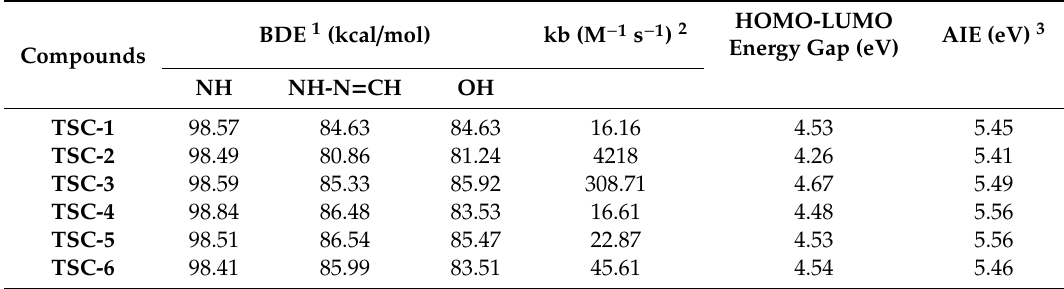
Table 2. Rate constants(kb) for radical scavenging, HOMO-LUMO energy gap, bond dissociation enthalpy (BDE) and adiabatic ionization energy (AIE) values of compounds.